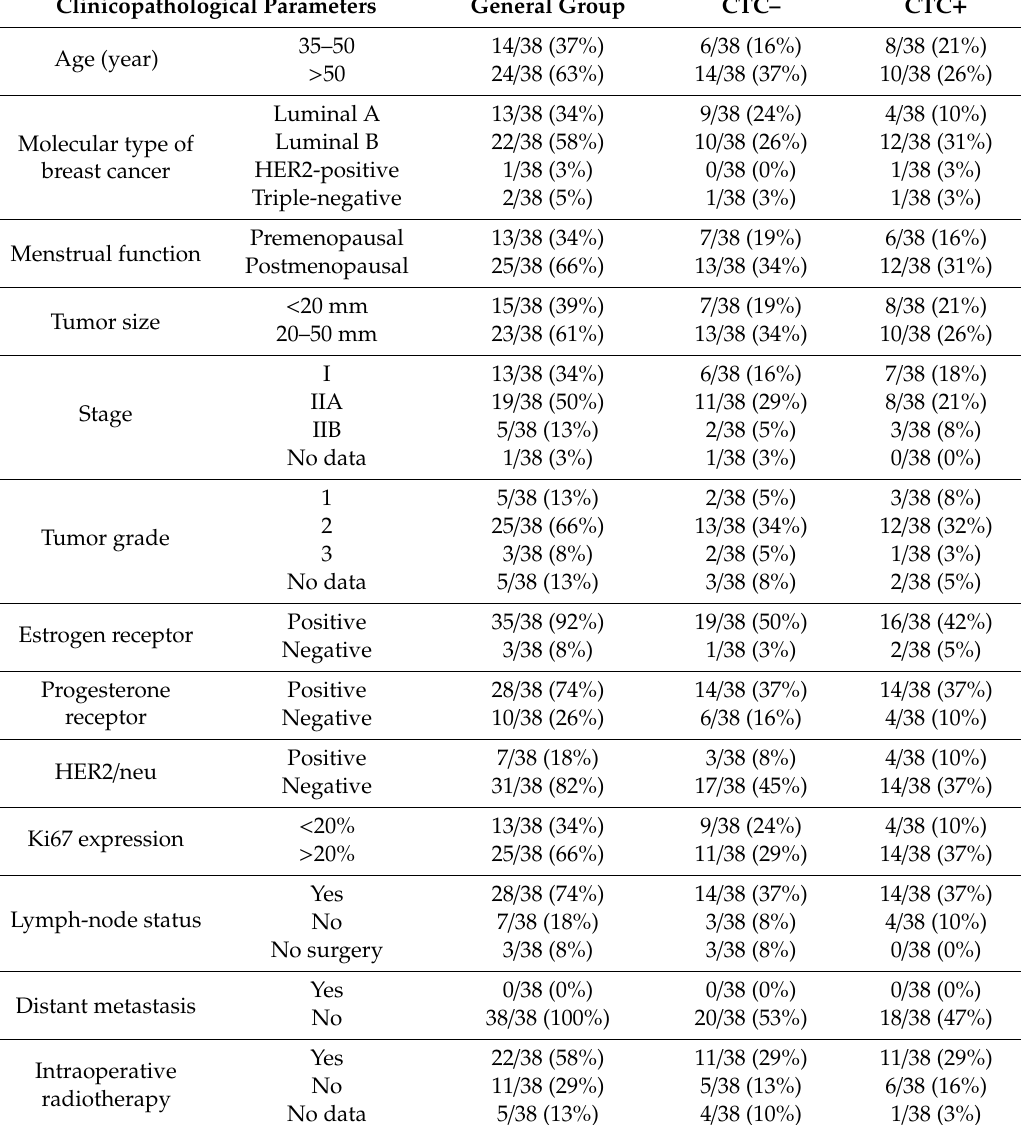
Table 1. Clinicopathological parameters of breast-cancer